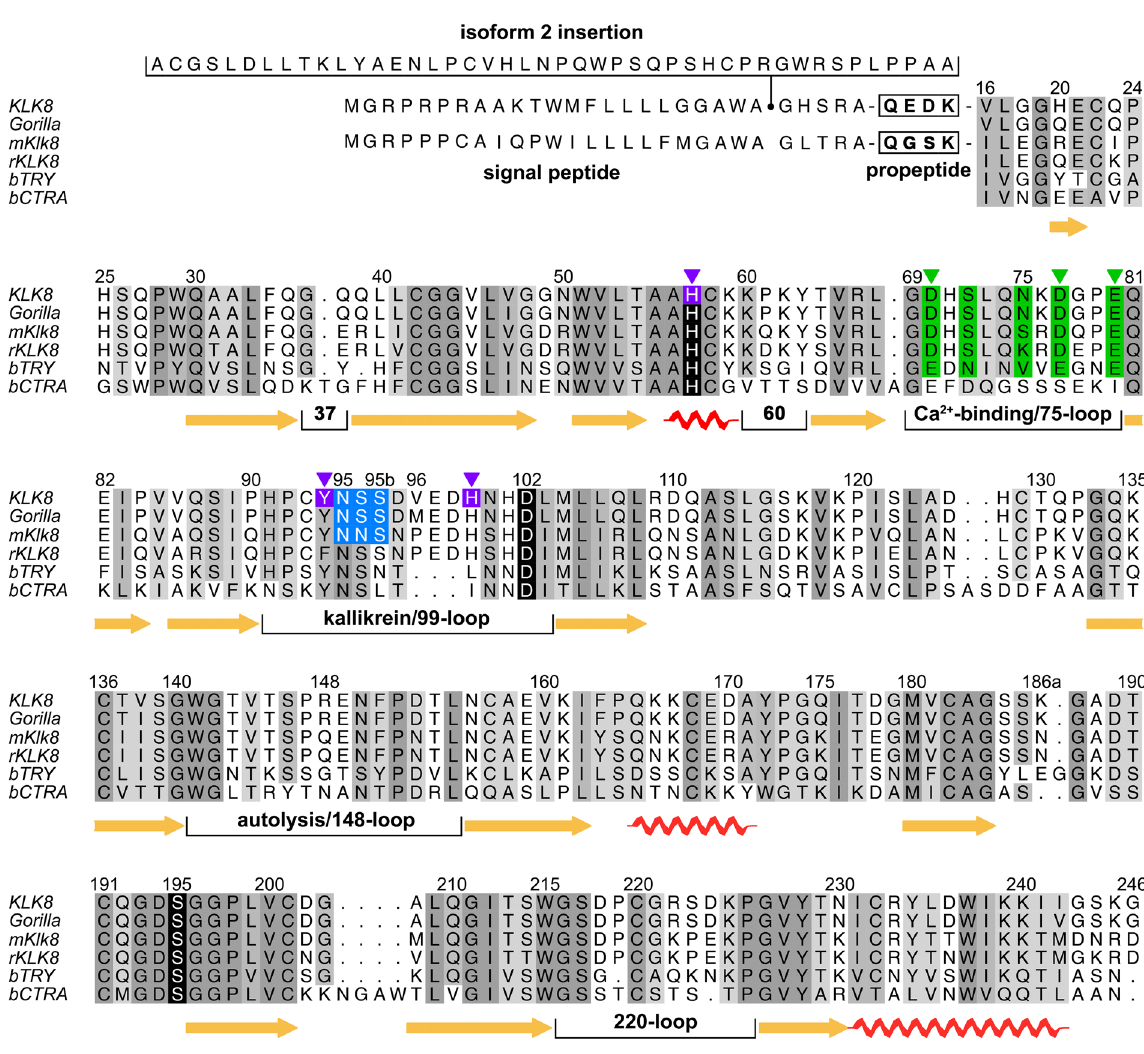
chymotrypsinogen A (bCTRA) as numbering standard. Signal peptides of isoforms precede the propeptide, whereby isoform 2 with a 45 residue insertion is supposed to be unique for humans. Human and chimpanzee KLK8 are identical, whereas the gorilla has three exchanges. Mice share 73% identical residues in KLK8 with humans, similar to rats with about 71%. β -sheets, α -helices, and the short 3 10 -helix (residues 56–59) of KLK8 are indicated by arrows and screws, respectively. Relevant surface loops are labeled according to the central residue. Darker shades of grey represent higher conservation, while the catalytic triad residues are depicted with black background. Ca 2 + -ligands are displayed with green background and Zn 2 + ligands are shown with magenta background, triangles indicate interacting side chains. The sequons of the glycosylation site at Asn95 are highlighted in